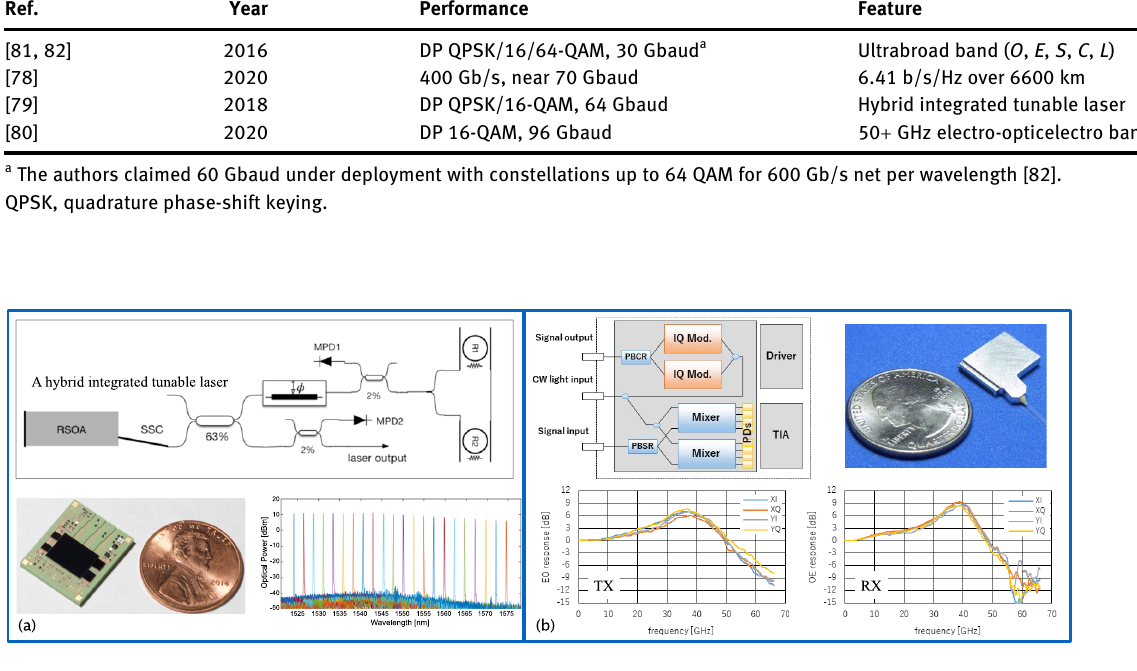
Figure 7: Silicon photonic coherent transceiver subassemblies. (a) a 64-Gbaud coherent transceiver with a hybrid integrated tunable laser [79] (top: block diagram of the hybrid integrated tunable laser; bottom left: photograph of the transceiver subassembly; bottom right: tuning performance of the laser); (b) a 95-Gbaud coherent transceiver with a bandwidth >50 GHz [80] (top left: block diagram of the coherent optical transceiver; top right: photograph of the packaged transceiver; bottom: transceiver (TX) and receiver (RX) frequency